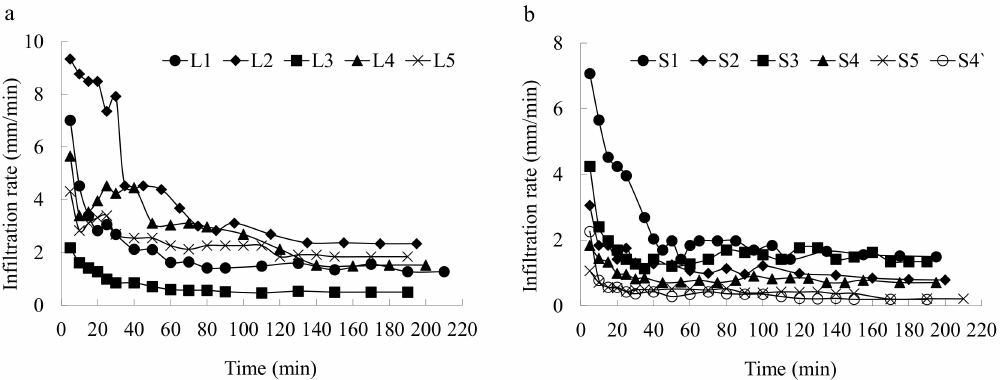
Figure 2. Permeability of loess–paleosol sequence in the Chinese Loess Plateau southern. Note: S4 (cid:48) is CaCO 3 concretion layer, ( a ) Loess, ( b )